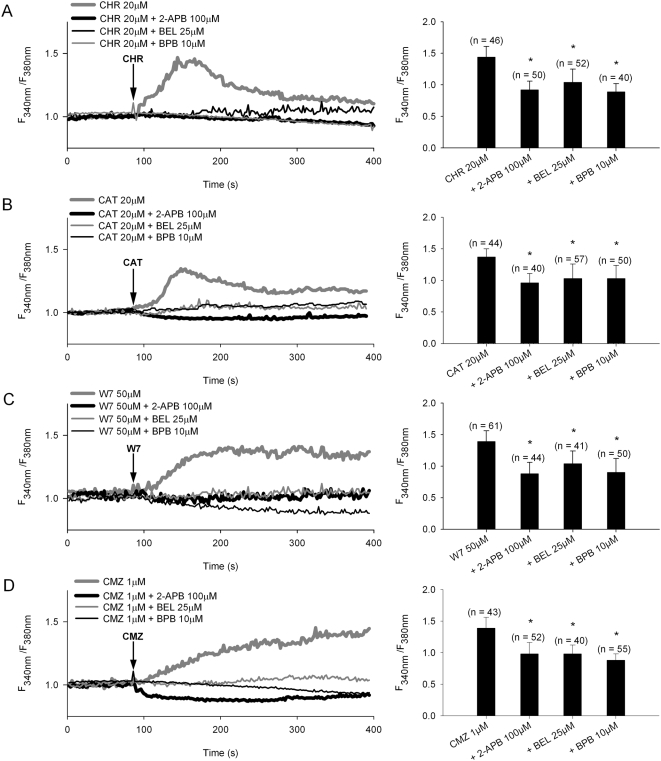
Involvement of iPLA2 in Ca2+ entry evoked by CHR and CAT in PMNs.A–D) Left panels: Effects of the SOC blocker (100 µM 2-APB) and inhibitors of iPLA2 (25 µM BEL) and PLA2 (10 µM BPB) on Ca2+ entry evoked by 20 µM of CHR or CAT, and two CaM antagonists (30 µM W7 and 1 µM CMZ). The representative traces show the average change in intracellular Ca2+ concentration (Fura-2 ratio, F340/F380) recorded simultaneously in a number of individual PMNs at 37°C. The following inhibitors were added: BEL (30 min), BPB (10 min) and 100 µM 2-APB (2 min) before addition of peptides or CaM antagonists (at arrows). Results are obtained from at least three independent experiments. Right panels: Bars represent the maximum Ca2+ influx (Ratio±S.E.) in different treatments (indicated below each bar); (n) number of PMNs; * p<0.05, significance for difference from peptide or CaM antagonist alone.